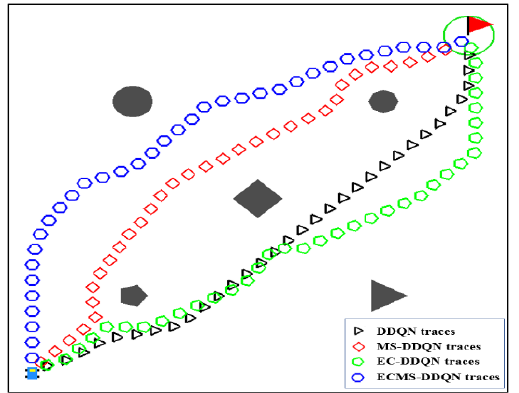
Figure 5. The path given by four algorithms in a fixed position scene.